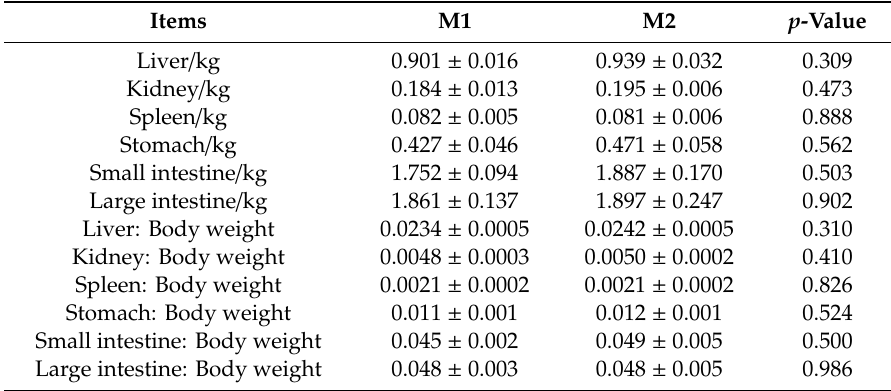
Table A2. E ff ects of feeding frequency on organ weight and their percentage in growing pigs 1